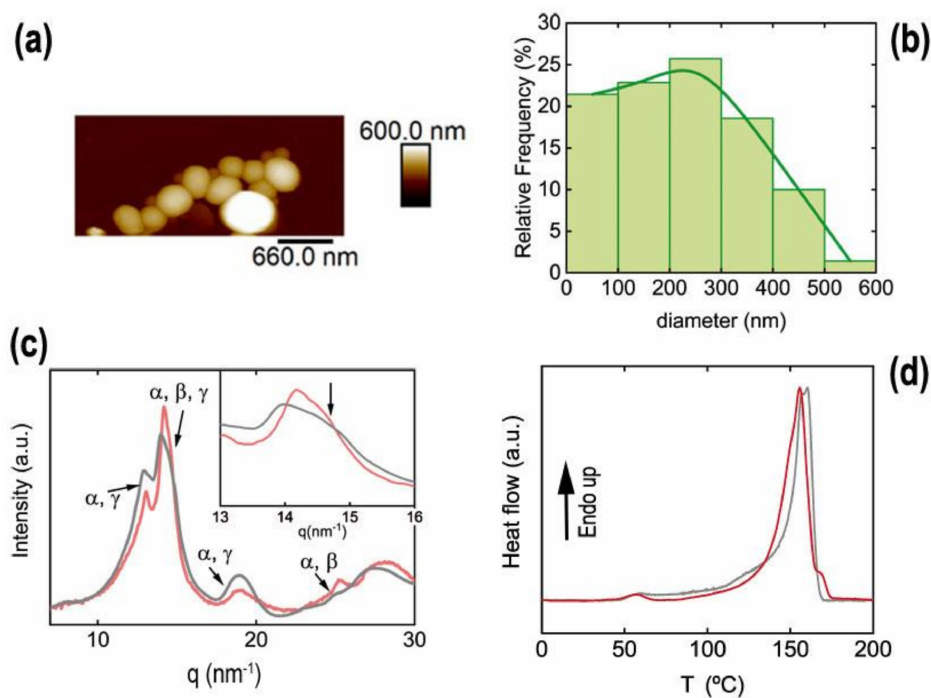
Figure 6. ( a ) Topographical image taken by AFM of PVDF nanoparticles prepared by dialysis technique; ( b ) histogram for the measured diameters; ( c ) X-ray diffracted intensity profiles for bulk PVDF processed from dimethyl acetamide (DMA) solution (black curve) and PVDF nanoparticles (red curve). Both diffractograms are normalized by setting the intensity maximum of this q range as 1 and the minimum as 0. The inset is a magnification of the zone of the most intense peak. The labels indicate the possible crystalline phases that would have a reflection in that particular position; ( d ) differential scanning calorimetry (DSC) heating ramps of PVDF film dried from DMA solution (black curve) and PVDF nanoparticles (red